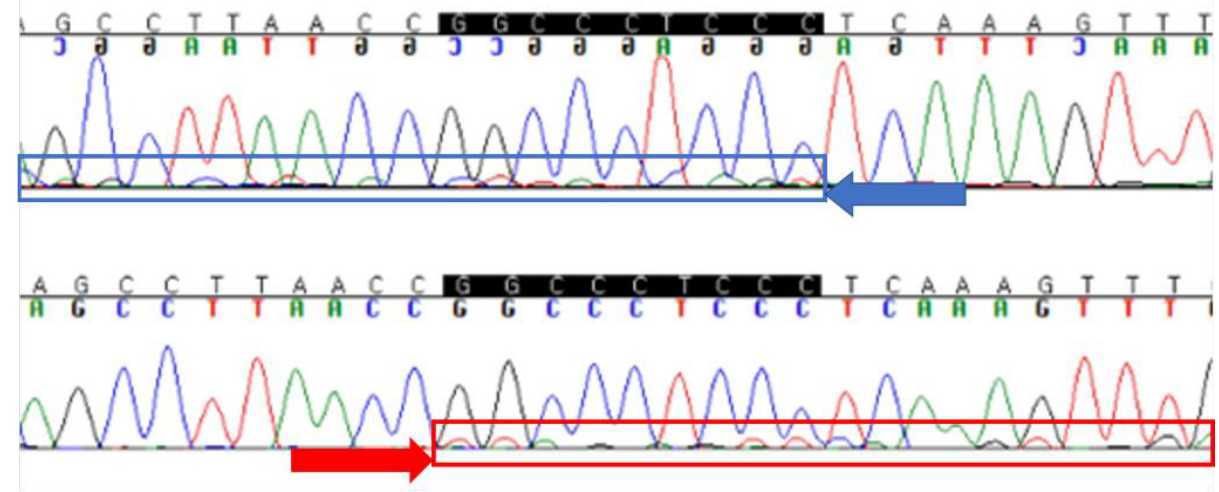
Figure 3. Corresponding indel variant via Sanger sequencing. The same indel variant as in Figure 2 can be confirmed by its forward sequence with the indel variant (red arrow and box) and the reverse sequence with the indel variant (blue arrow and box). We conclude that the variant is somatic because of the following four reasons. Initially, we could not find any neurofibromatosis symptom including caf é -au-lait spots, freckling, or multiple cutaneous neurofibromas. However, pathogenic germline NF1 mutation has almost 100% penetrance to neurofibromatosis [9]. Therefore, we thought the patient did not have the variant before the onset of the leukemia. Secondly, neurofibromatosis is an autosomal dominant inherited disorder [9]. This fact also lowers the possibility of germline mutation. Thirdly, variant allele frequency (VAF) of the found NF1 gene variant was 80%, which is not around 50% for heterozygous nor around 100% for homozygous germline variants. Finally, Sanger sequencing shows overlapped sequences which are the mix of wild-type sequence and the indel variant-induced sequence (in the red as well as blue boxes). If the variant is germline heterozygous, the overlapped sequence (in the red and blue boxes) should show that some nucleotides have almost the same amplitude of the two difference sequences. If the variant is germline homozygous, the overlapped sequence (in the red and blue boxes) should show only one indel variant-induced sequence. The found NF1 variant c.4691_4698delins(p.Leu1564Argfs*7) was an indel one, which consists of 8 base-pair deletion followed by 9 base-pair insertion. It causes frame-shift during translation from mRNA to protein and it introduces stop-codon after 7 codons. The result is the formation of a truncated Nf1 protein.